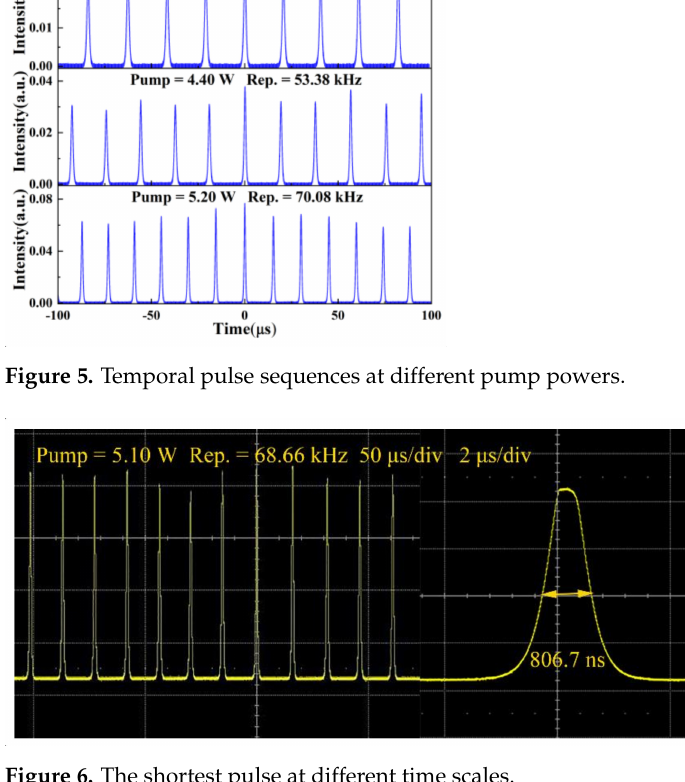
Figure 6. The shortest pulse at different time